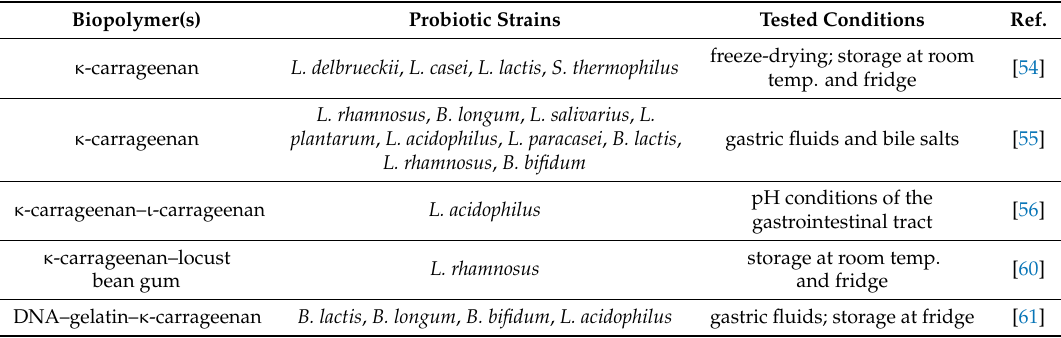
Table 2. κ -Carrageenan-based hydrogels used as delivery systems of selected probiotic strains.